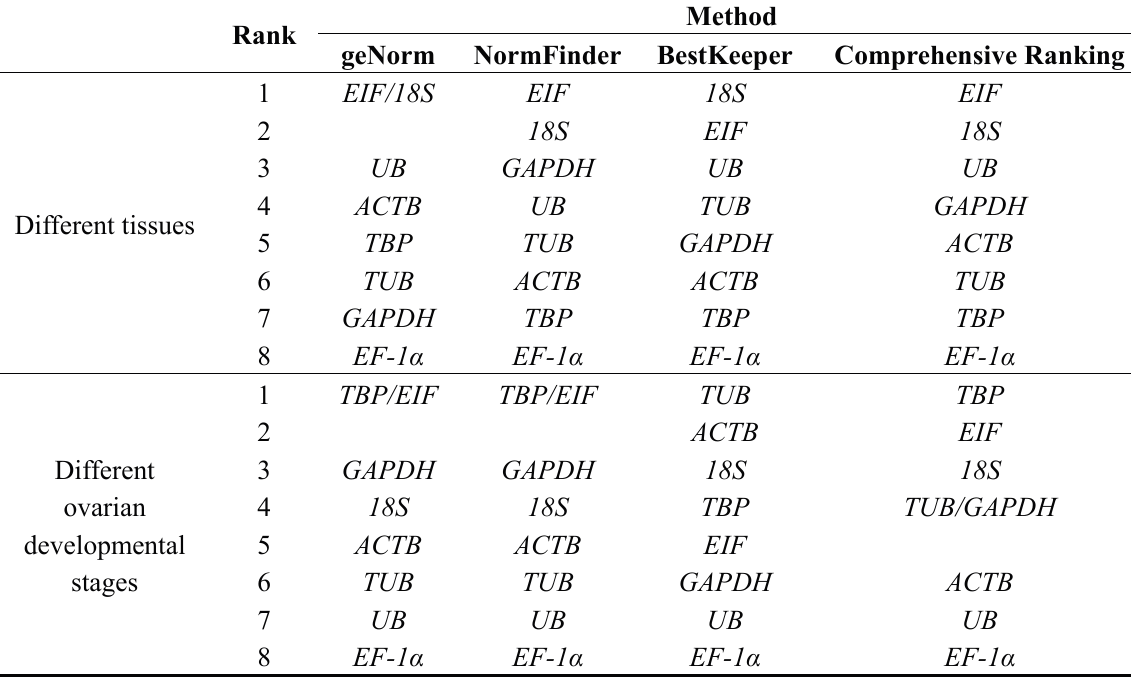
Table 2. Ranking of candidate reference genes under different experimental conditions. Method Rank geNorm NormFinder BestKeeper Comprehensive